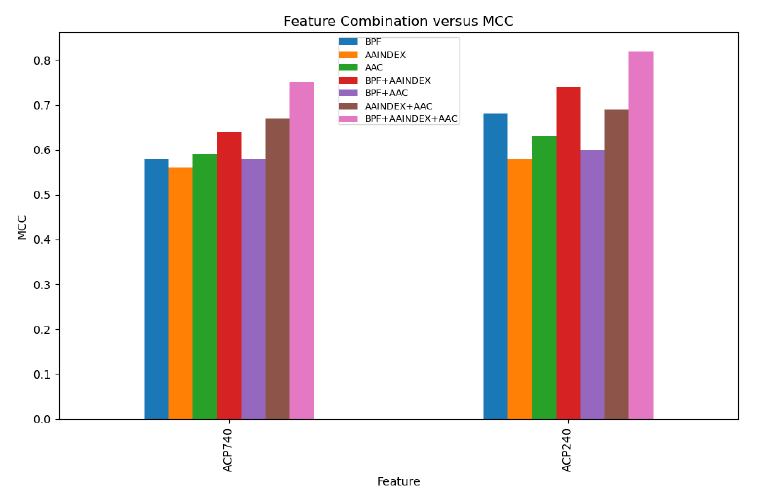
Figure 2. Comparison of feature efficacy for prediction using the BPF, AAINDEX, AAC, and their possible concatenations on the ACP740 and ACP240 datasets.